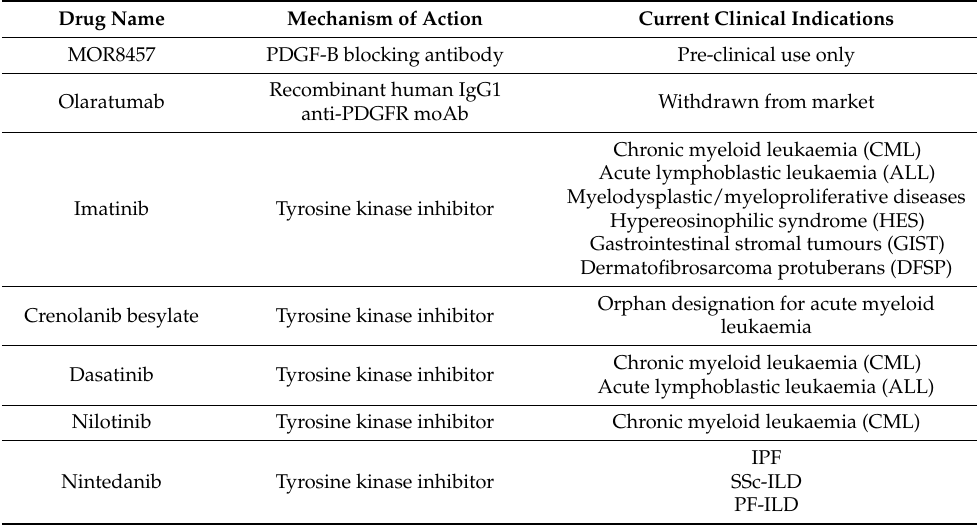
Table 1. Drugs targeting PDGF/PDGFR and their clinical applications. Abbreviations: moAb, monoclonal antibody; IPF, idiopathic pulmonary fibrosis; SSc-ILD, systemic sclerosis-associated interstitial lung disease; PF-ILD, progressive fibrosing interstitial lung